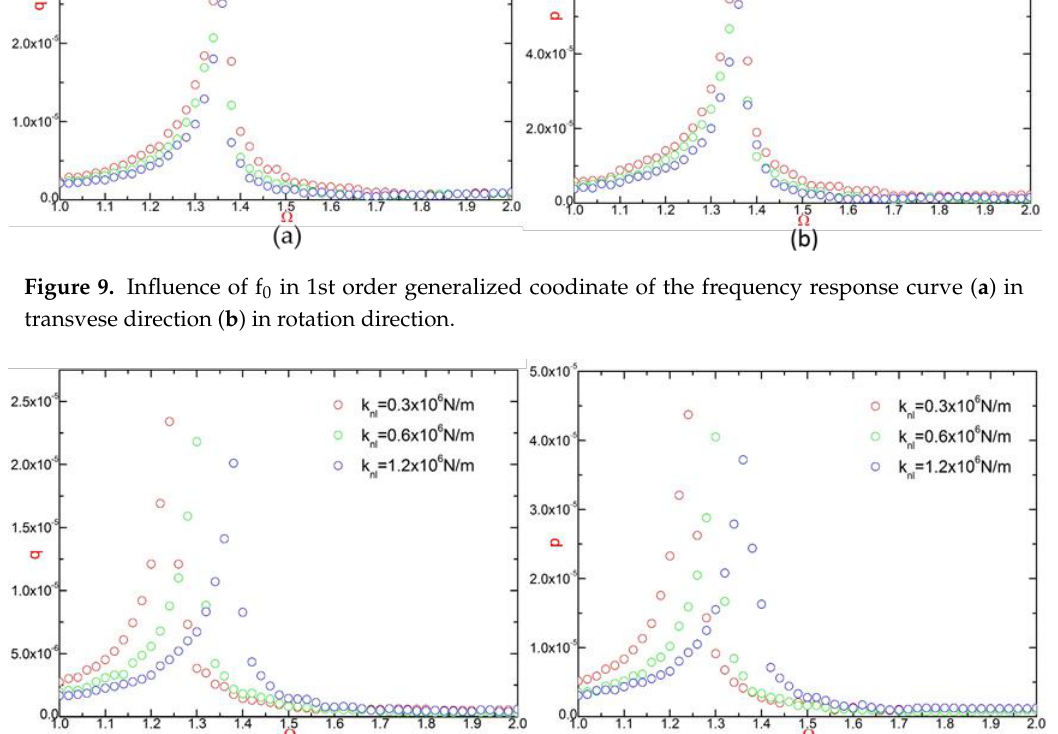
Figure 8. Influence of η in 1st order generalized coodinate of the frequency response curve ( a ) in transvese direction ( b ) in rotation direction.